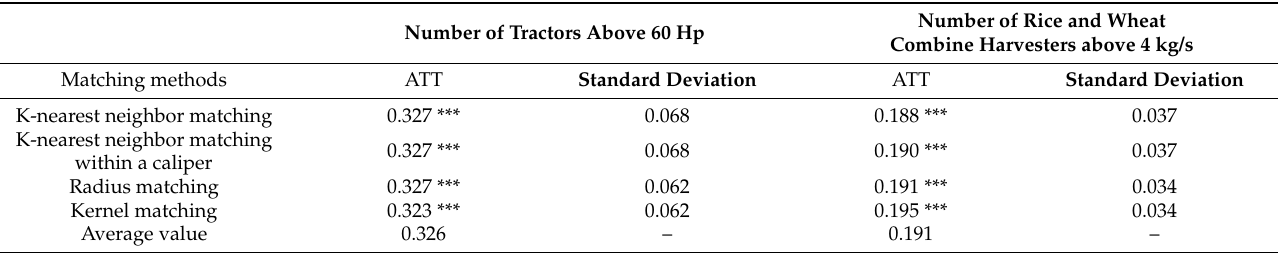
Table 7. Results of PSM (amount of large- and middle-sized agricultural